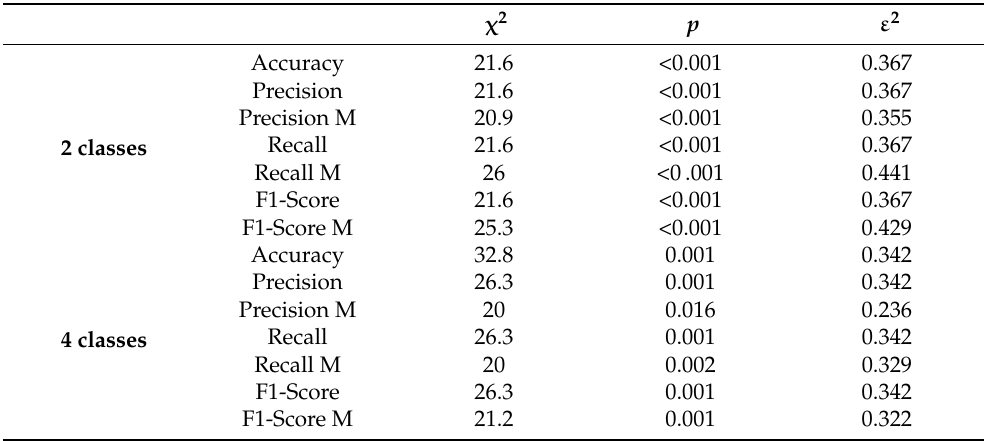
Table 5. Kruskal–Wallis analysis between Linear model and Machine Learning models, respectively, using 2 and 4 classes of outcome with MRMR